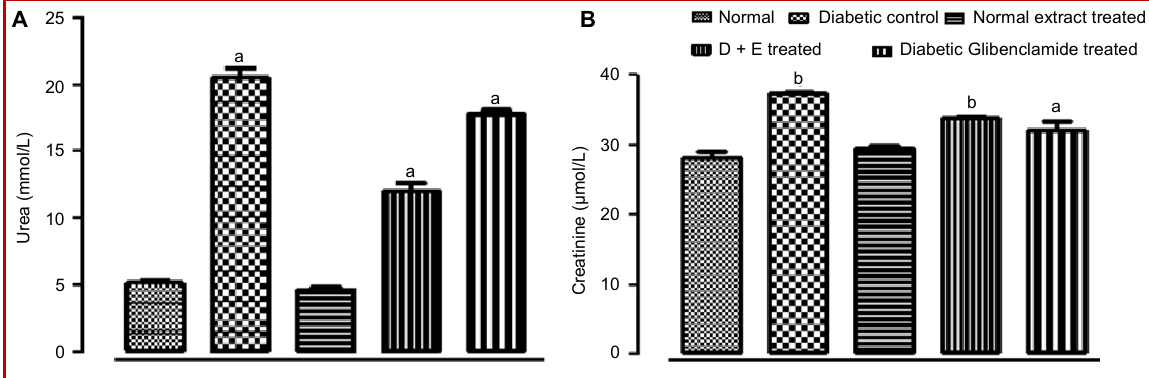
Figure 2: Effect of extract and standard drug on serum urea (A) and creatinine (B) levels of normal and alloxan-induced diabetic mice. Data represented as mean ± S.D values of 6 animals each a p<0.001, b p<0.05 (One- way ANOVA, Dunnet’s t -test, GraphPad Prism software); “D + E” means extract -treated in diabetic